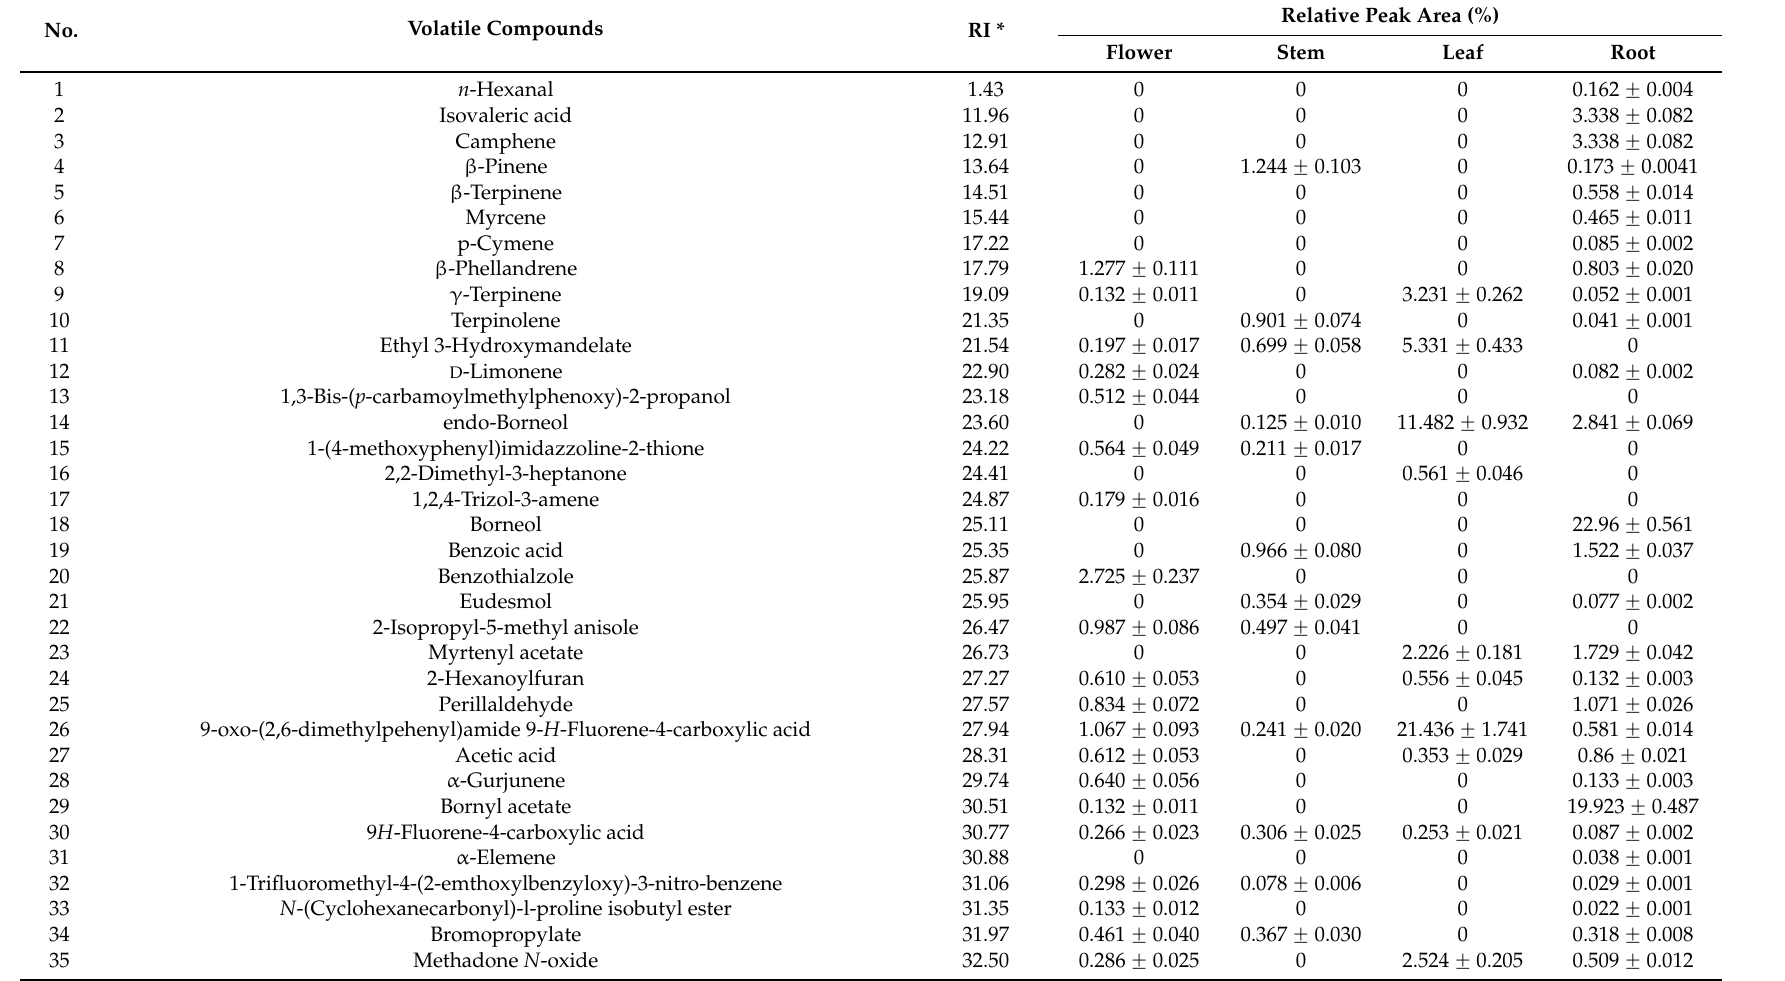
Table 1. Composition of volatile compounds in different organs from V. fauriei